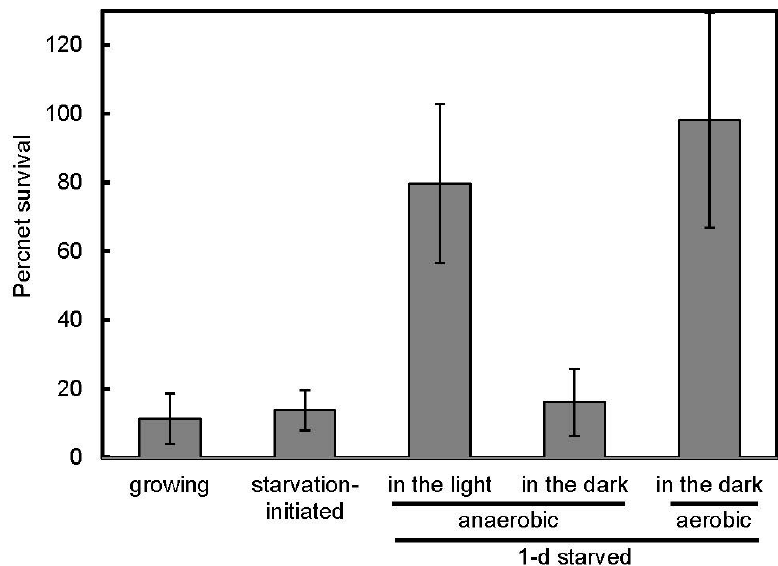
Figure 1. Survivability after exposure to salt stress. CFU values after incubation in 2.5 M NaCl for 1 h in the dark were determined for exponentially growing cells (growing), starvation-initiated cells (starvation-initiated), 1-d anaerobic starved cells in the light, 1-d anaerobic starved cells in the dark, and 1-d aerobic starved cells in the dark. The percent survival was calculated as a percentage of CFUs after incubation without NaCl. Error bars indicate standard deviation of three or four biological replicates.